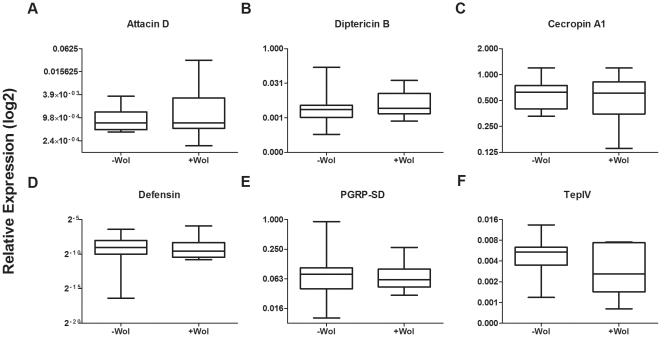
Immune gene expression in response to Wolbachia infection.The relative expression (RE) of immune genes of D. melanogaster with and without Wolbachia was analysed using RT-qPCR. The box and whisker plots show the ratio of immune to reference gene (RpL32) expression from the indicated genes: (A) Attacin D, (B) Diptericin B, (C) Cecropin A1, (D) Defensin, (E) PGRP-SD and (F) TepIV. Boxes represent medians, 25 (bar below median) and 75 (above median) percentiles of 10 individual male flies. None of the medians were significantly different (Mann Whitney-U test; p>0.05).